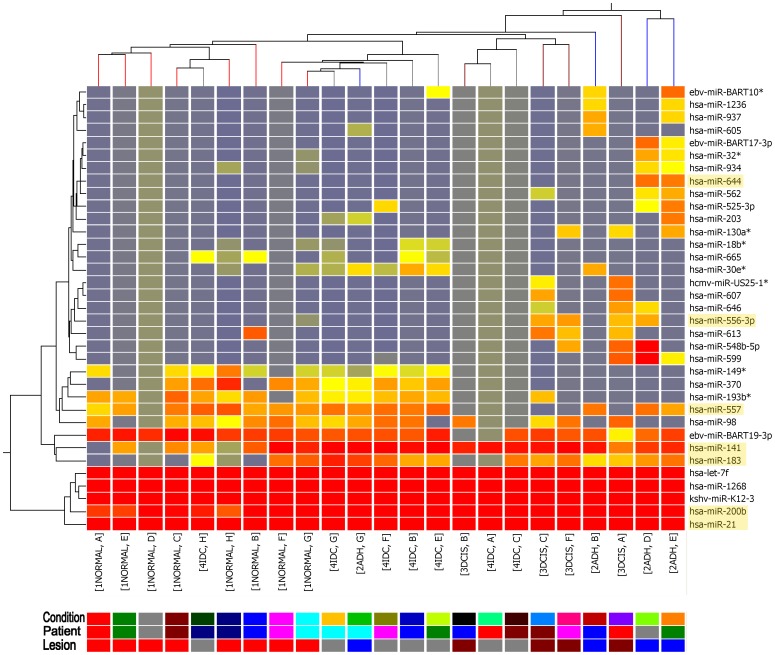
Unsupervised clustering results on ANOVA identified miRNAs and conditions of the 23 samples.Each solid color box represents a certain condition. The clustering result indicates the significantly altered miRNA entities identified by ANOVA test have more potential to distinguish different stages of breast cancer than broad-wide miRNAs. Seven individual clusters were clearly discerned by the clustering algorithms and the miRNAs circled by red rectangles representing their discrete clusters.